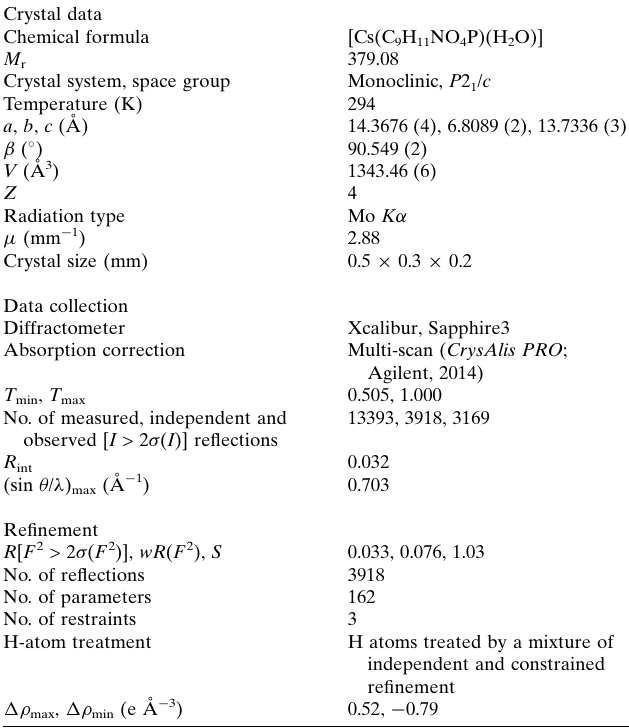
Table 3 Experimental details. Crystal data Chemical